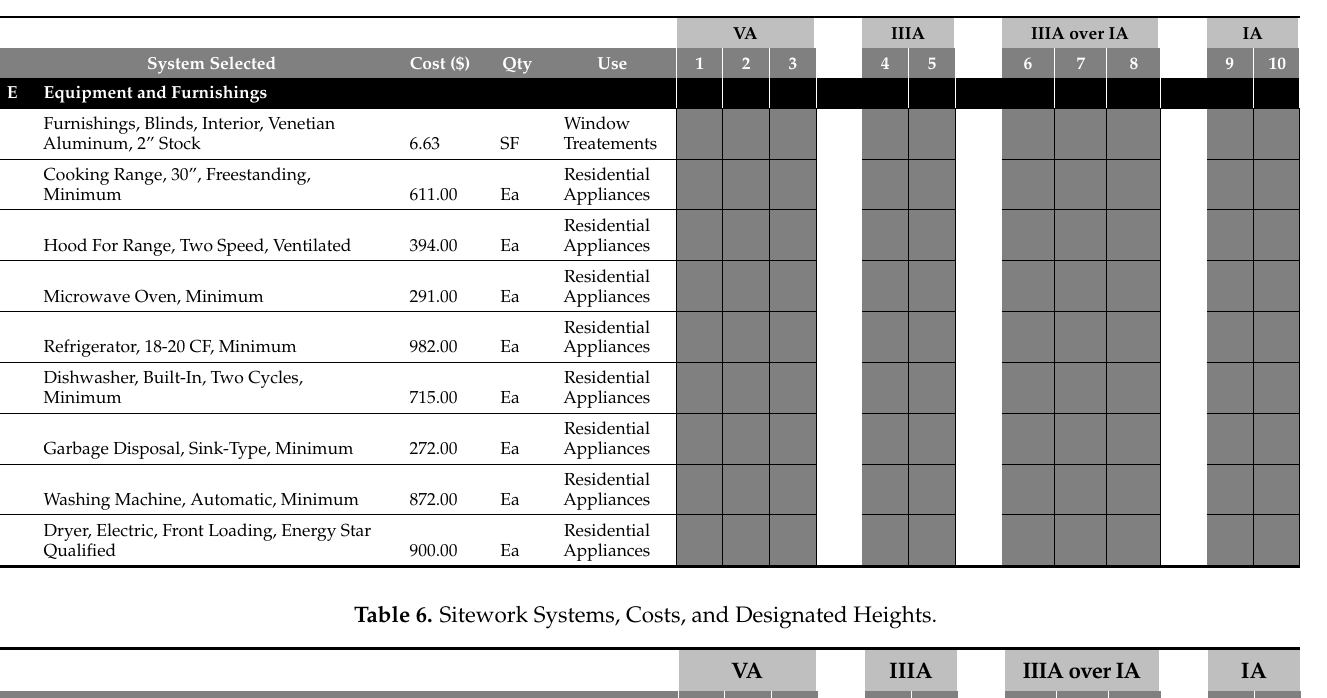
Table 5. Equipment Systems, Costs, and Designated Heights.